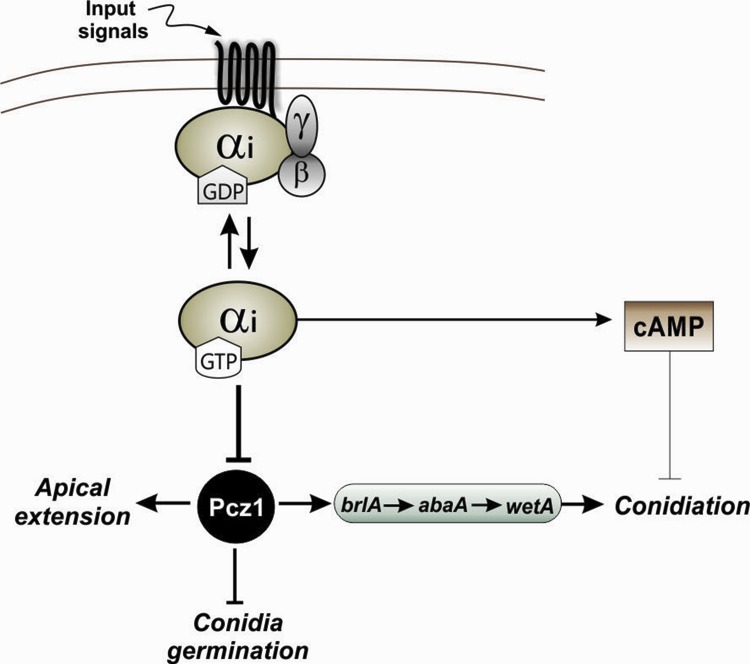
A working model showing developmental processes controlled by pcz1 in P. roqueforti.The model includes the suggested relationship between pcz1 and the Gαi subunit, and the existence of cAMP-independent and cAMP-dependent pathways related to conidiation. The thickness of the line indicates the magnitude of the effect. The model includes effects inferred by experimental data from this work and previous results [8,9]. See the main text for details.